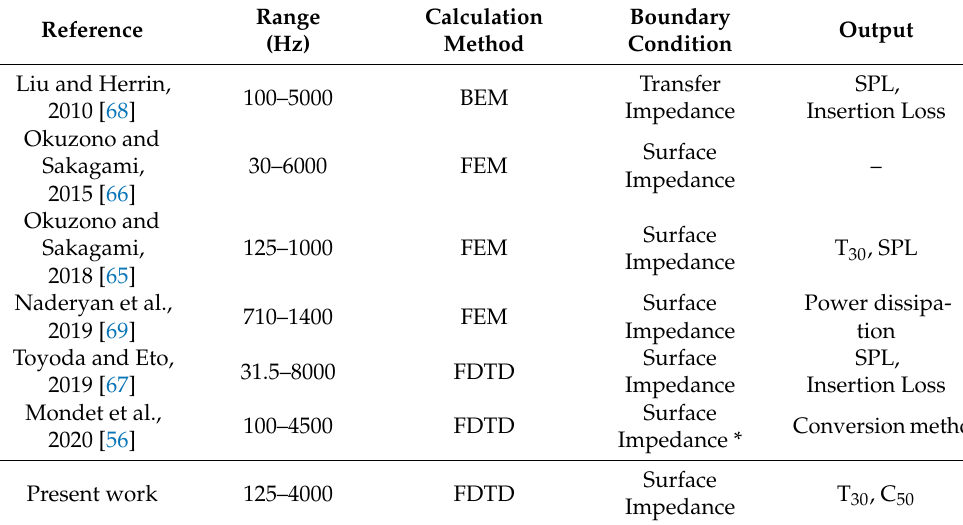
Table 7. Framework of recent works focused on wave-based simulations of micro-perforated panels. The frequency range managed by the authors, the calculation method, the typology of boundary condition employed and the output parameters obtained are